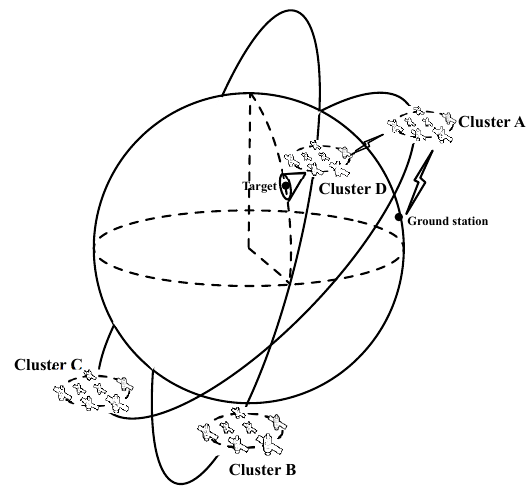
Figure 1. Illustration of satellite cluster networks (SCNs) with multi-clusters.